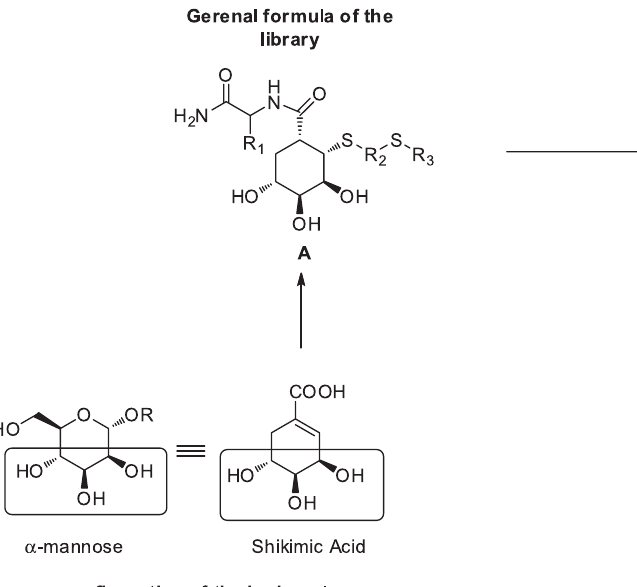
FIGURE 3 - Shikimic-based derivatives as ligands for